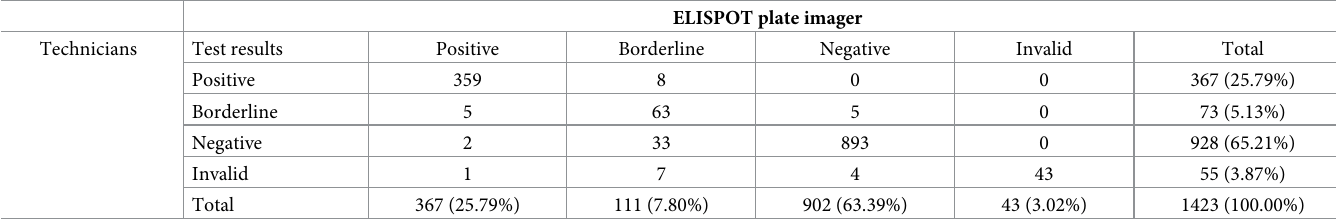
Table 1. Comparison of the qualitative test results read by the technicians and ELISPOT plate